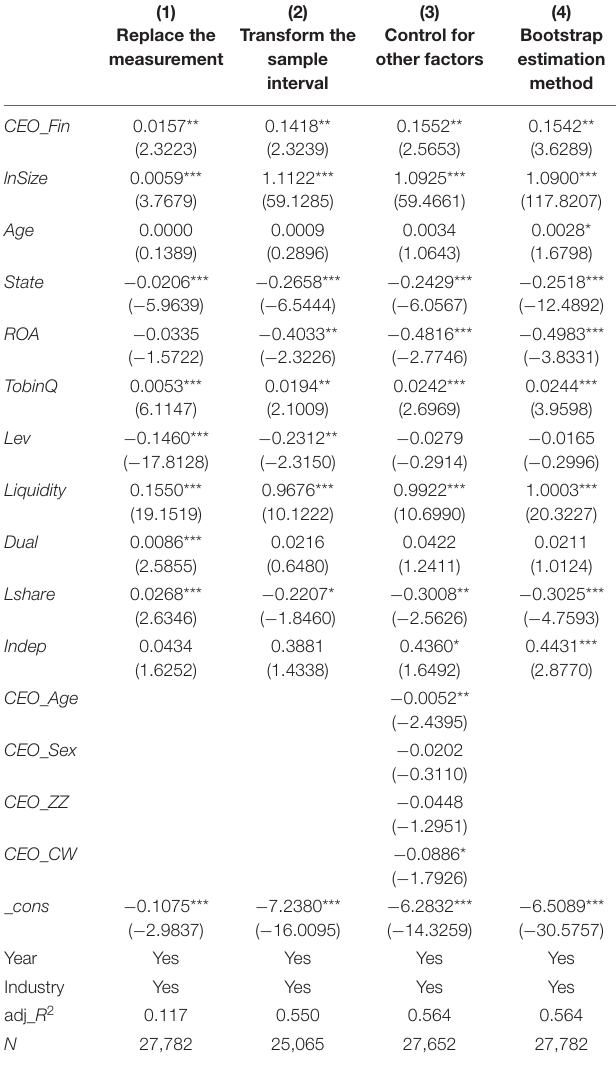
TABLE 4 | Replace the measurement of the explained variable, transform the sample interval, control for other factors, and change the parameter estimation method.